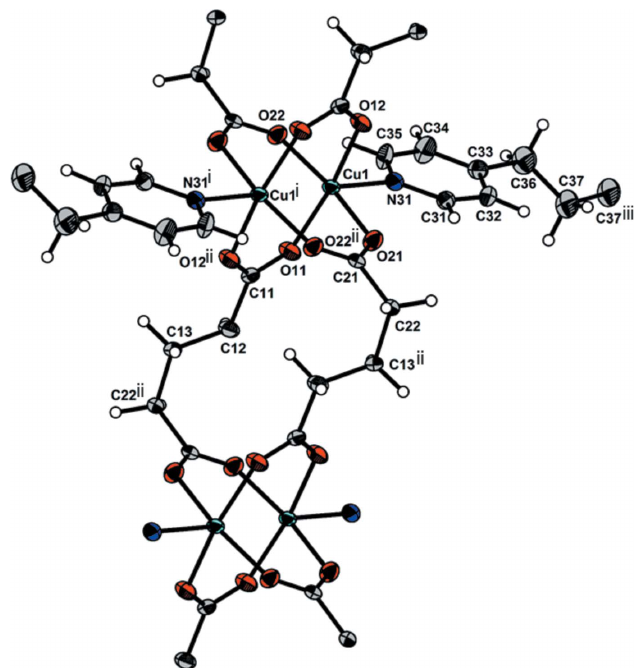
Figure 1 A fragment of the title compound, showing displacement ellipsoids at the 30% probability level. [Symmetry codes: (i) 1 (cid:5) x , 1 (cid:5) y , 2 (cid:5) z ; (ii) 1 (cid:5) x , (cid:5) y , 2 (cid:5) z ; (iii) 3 (cid:5) x , 1 (cid:5) y , 1 (cid:5) z